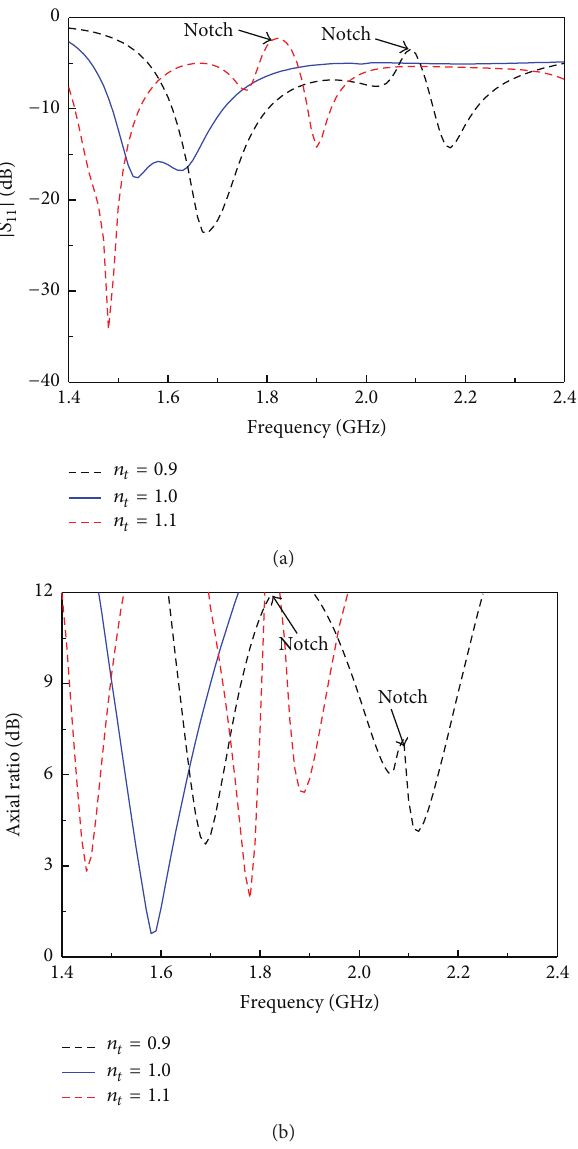
Figure 7: Simulated (a) |𝑆 11 | and (b) AR values of the four-arm curl antenna shown in Figure 6 for different 𝑛 𝑡 (𝑛 𝑏 = 1 was fixed )